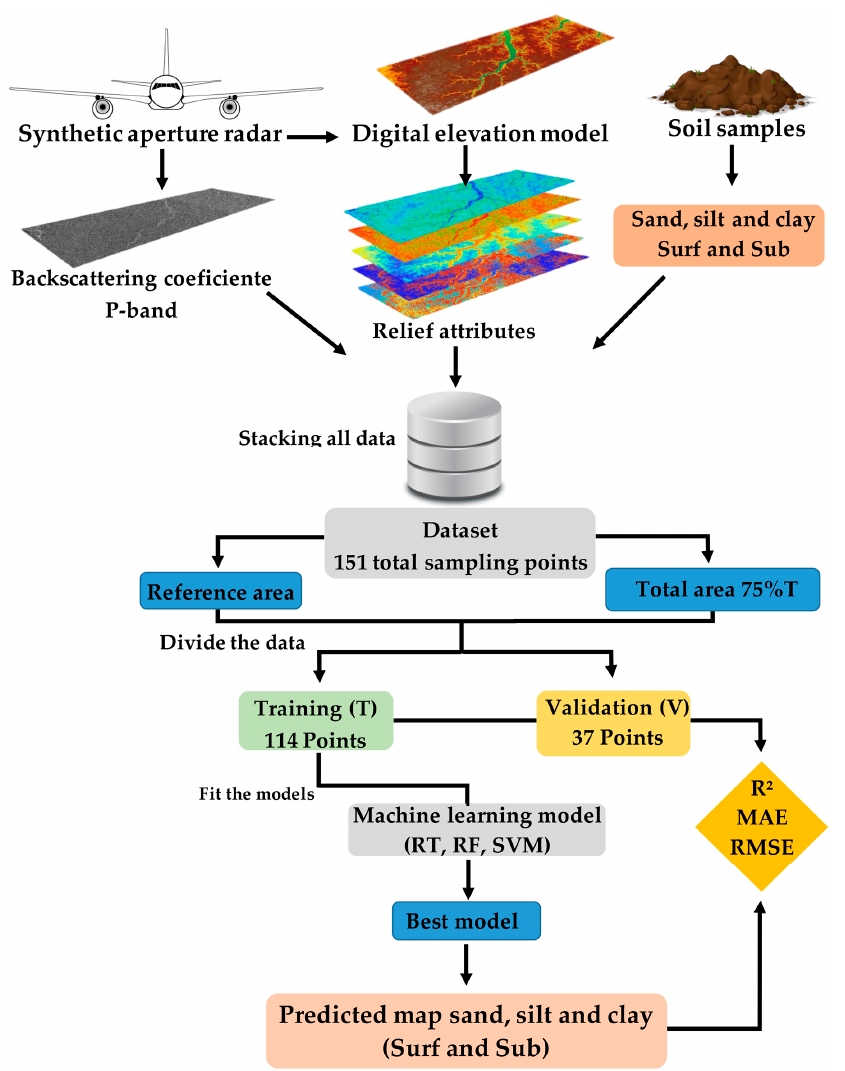
Figure 2. Flowchart of the methodology used for mapping soil surface (Surf) and subsurface (Sub) clay, silt, and sand contents. T—training; V—validation; RT—regression tree; RF—random forest; SVM—support vector machine; R 2 —coefficient of determination.